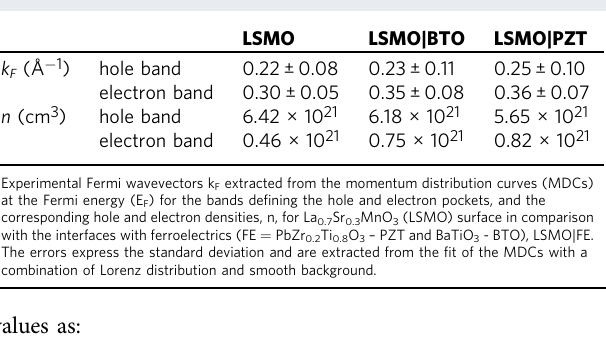
Table 1 Modulation of carrier concentrations.